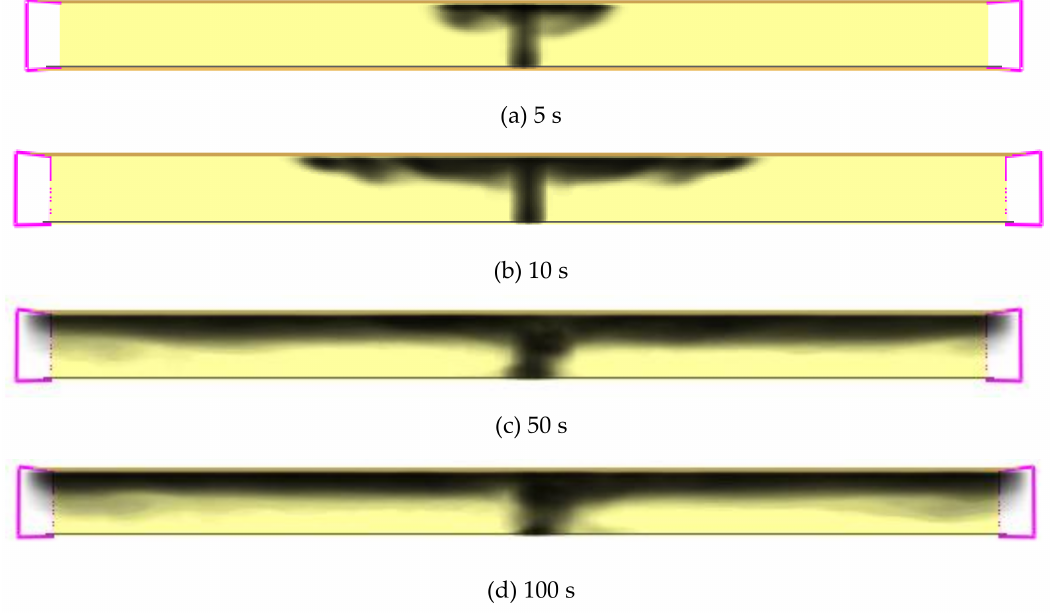
Figure 8. Smoke height distribution over time without fire retardant additive.